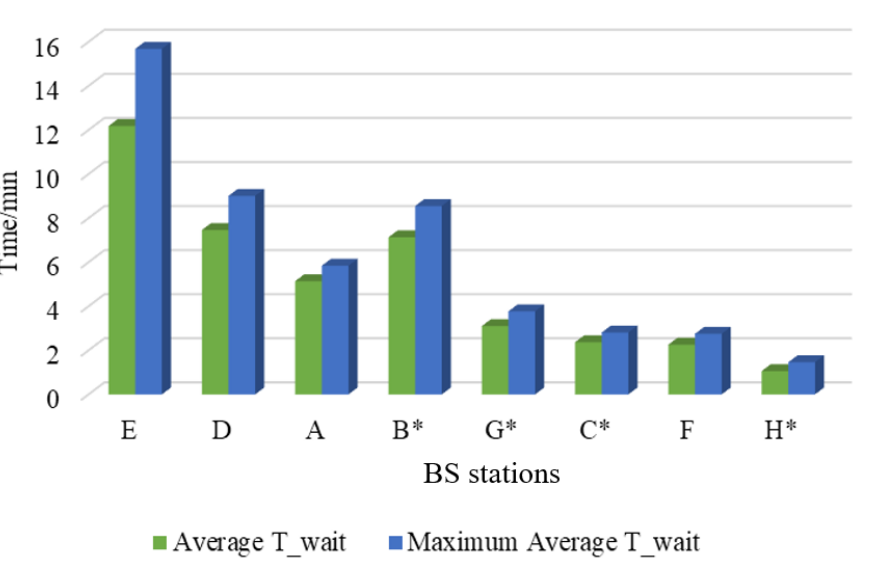
Figure 7. Comparison of waiting times. Based on the results, the service levels of different stations vary significantly. The utilization of some existing BS stations, especially Station E, have reached a level where a significant waiting time may